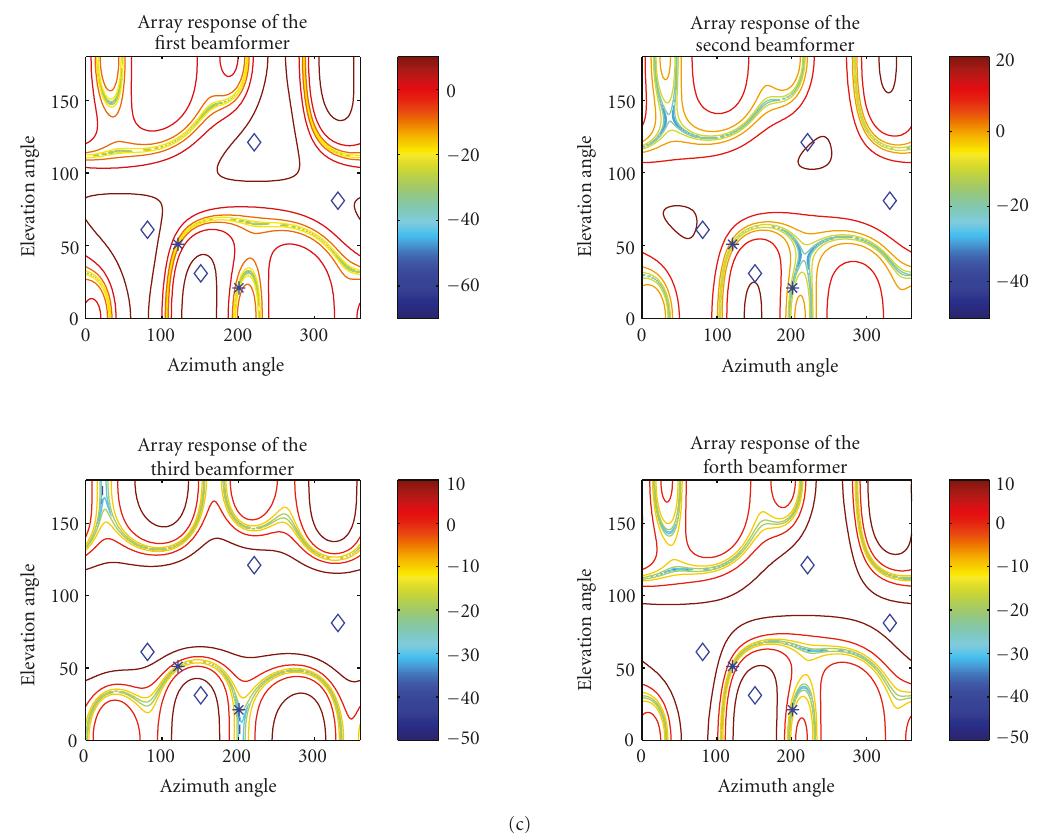
Figure 6: (a) Array response of the adaptive multiple MVDR beamformers with four RHCP jammers. (b) Array response of the adaptive multiple MVDR beamformers with two vertically polarized jammers. (c) Array response of the adaptive multiple MVDR beamformers with two horizontally polarized jammers.